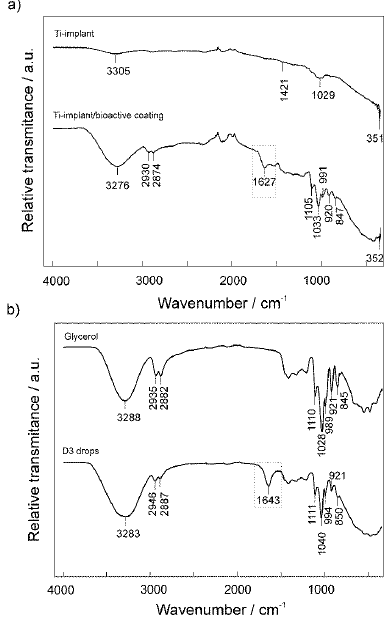
Figure 3. Attenuated total reflection Fourier transform infrared spectroscopy (ATR-FTIR) spectra of ( a ) the unmodified and modified Ti-implant surfaces and ( b ) D3 drops and glycerol.